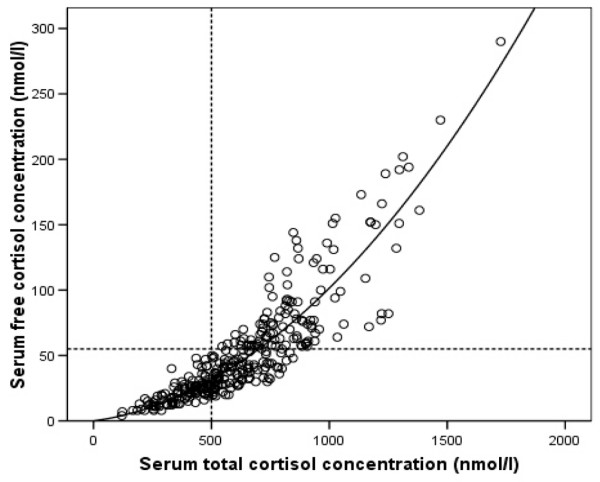
Pooled data and quadratic regression analysis. Equation from quadratic regression analysis for serum free cortisol concentration = 0.024 × serum total cortisol concentration + 0.0000772 × total cortisol concentration2. Pearson correlation coefficient 0.88, p < 0.001.